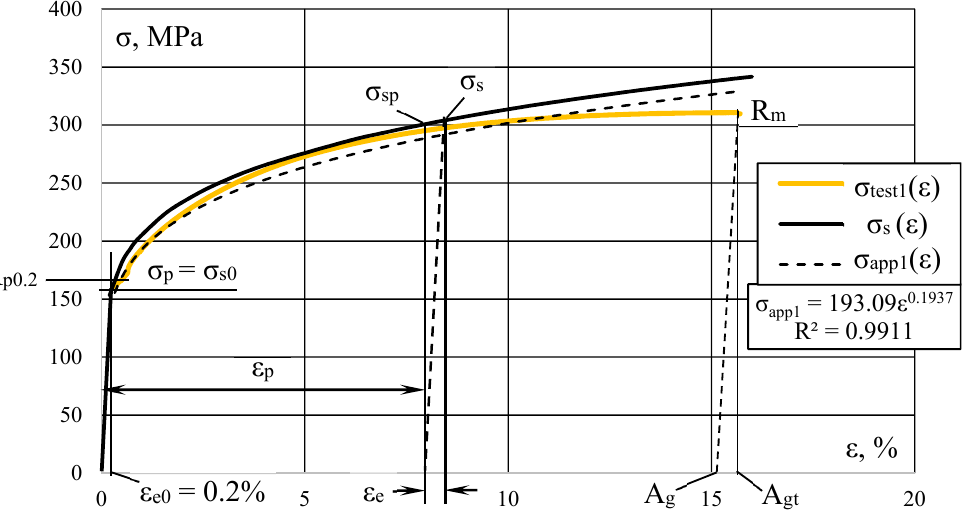
Figure 4. Approximation of test engineering stress-strain curves: σ test1 ( ε )—segment of representative curve based on single test data; σ app1 ( ε )—approximation function for single representative test; R 2 —coefficient of determination; σ s ( ε )—curve of general approximation function based on mean values of 10 tests; R p0.2 —proof strength at plastic extension 0.2%; R m —tensile strength at plastic A g and total A gt extensions; σ p —stress limit of proportionality at elastic strain ε e0 = 0.2%; ε p and ε e —elastic and plastic components of total strain (deformation) for flow stress value σ s